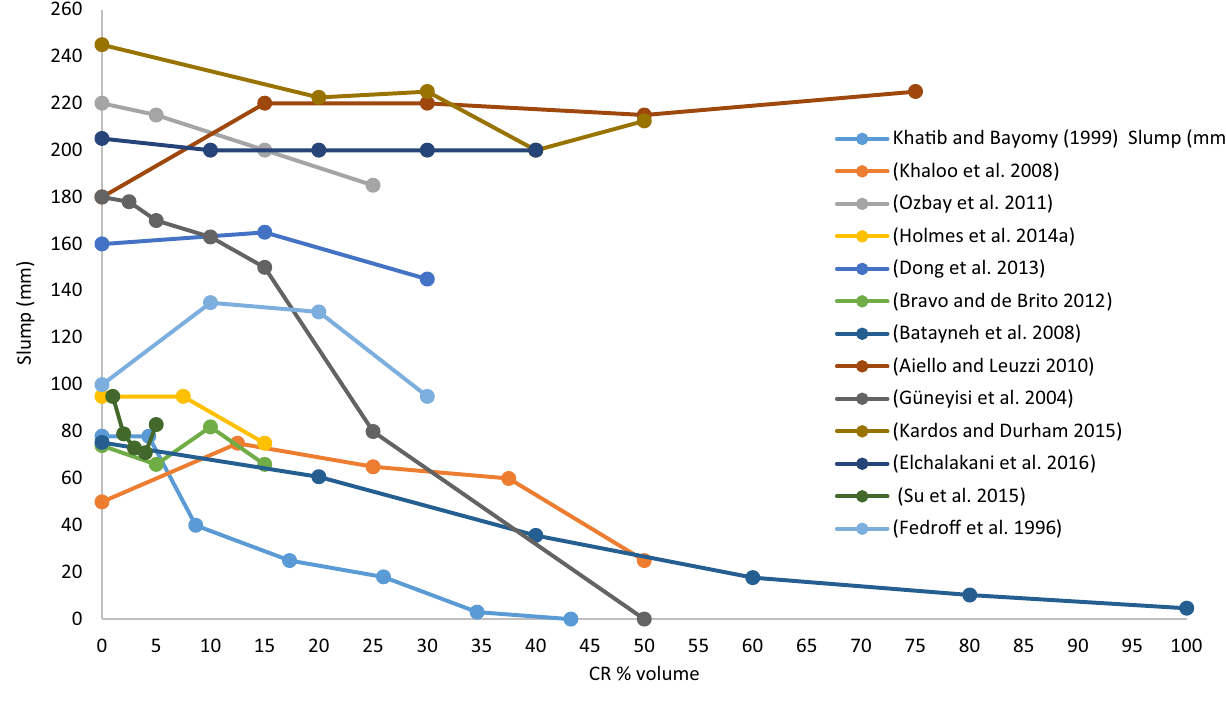
Fig. 3 Workability of concrete containing CR [8, 20, 25, 28, 29, 31, 32, 35, 53, 88,